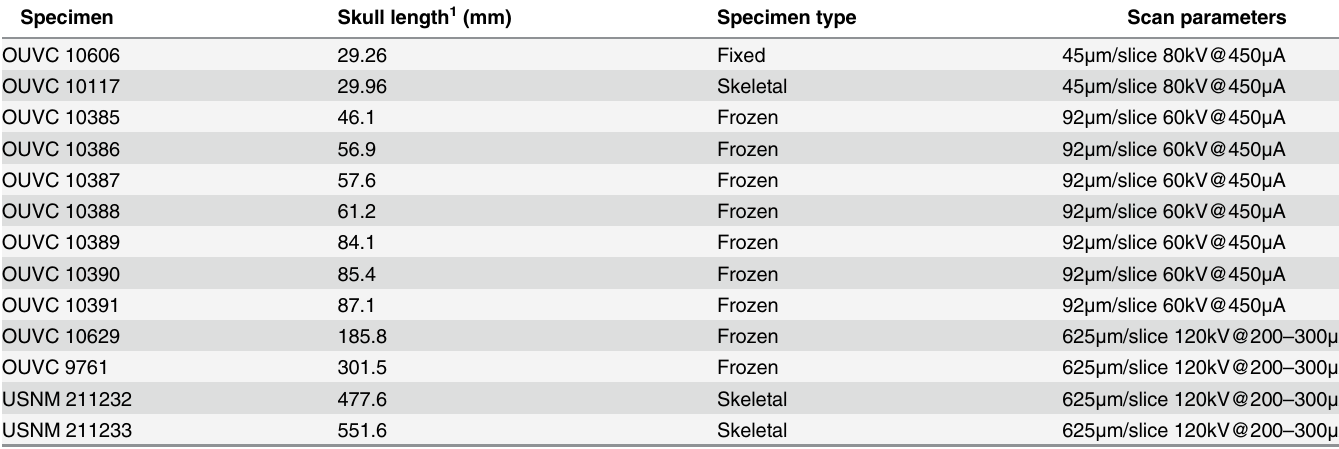
Table 1. List of Alligator mississippiensis specimens used in current study.